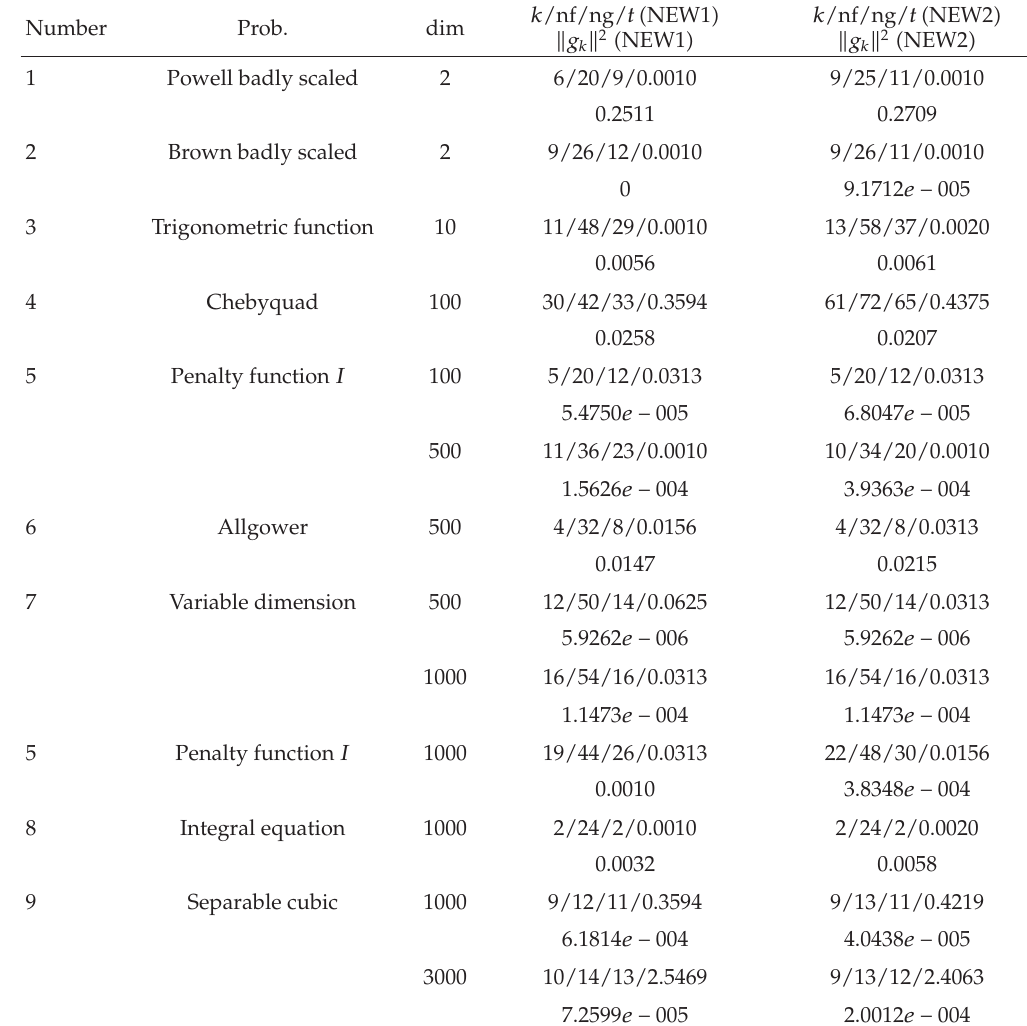
Table 1: Numerical results of the NEW1 and